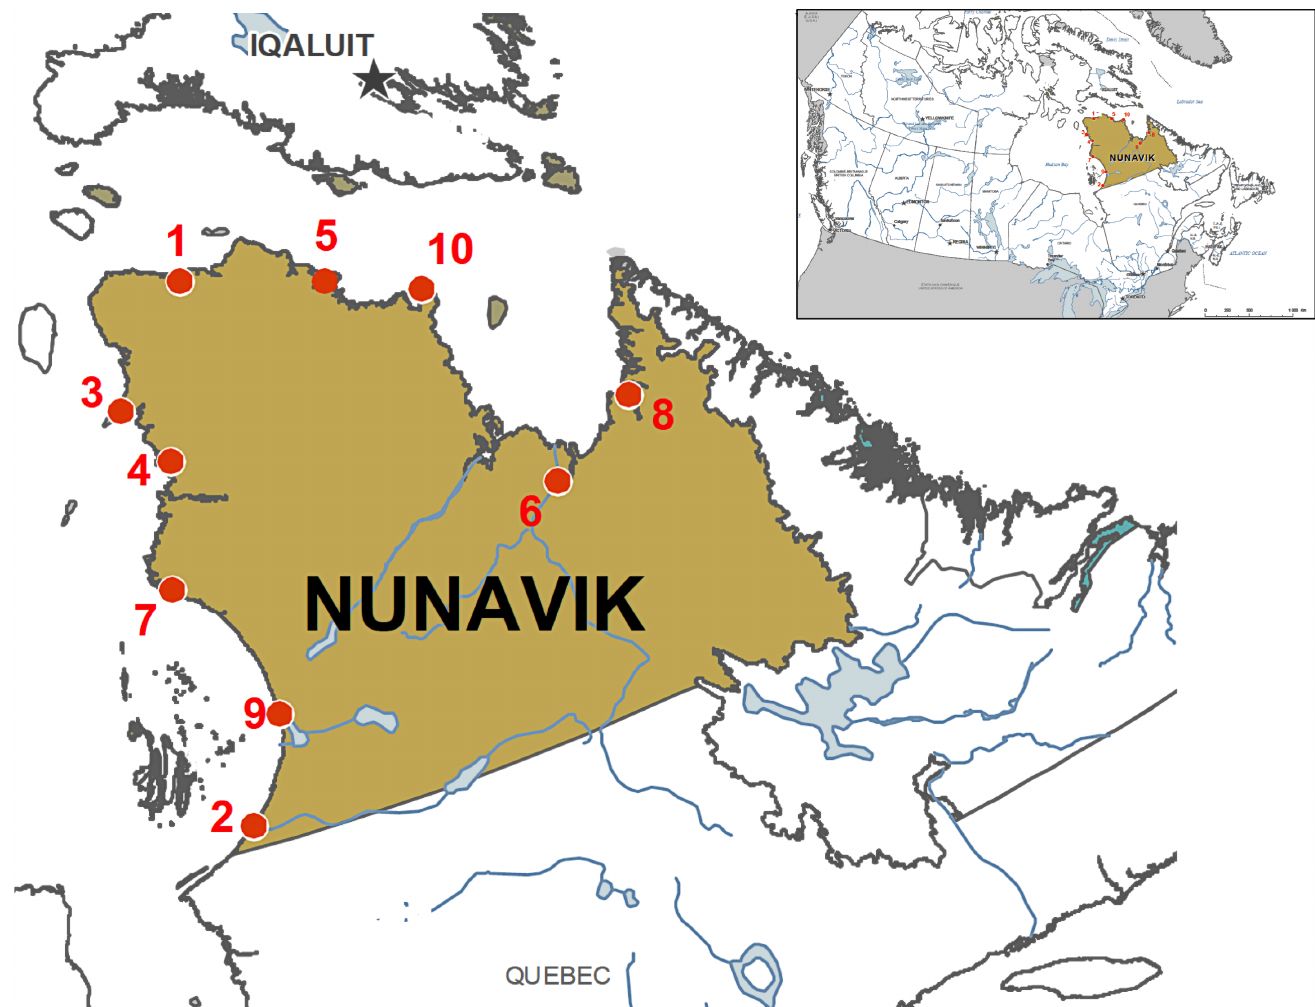
Fig 1. Map of the Nunavik region. Numbers correspond to the geographic location of villages described in the text.